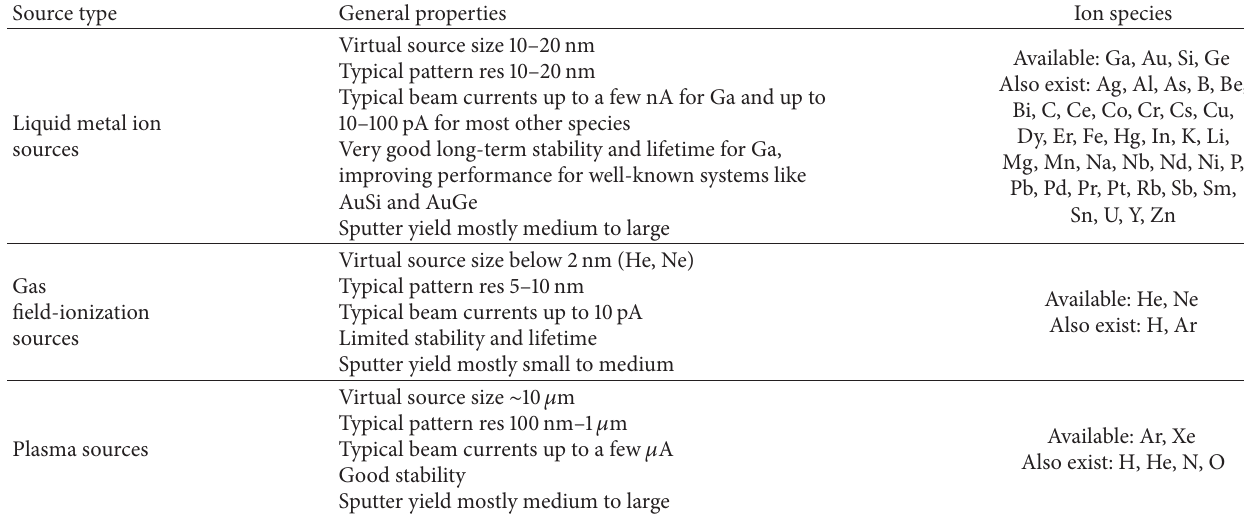
Table 3: Ion sources (list of LMIS sources from [7, 20, 22, 163]). The ion species listed as “available” are available from well-developed sources and are featured in commercial